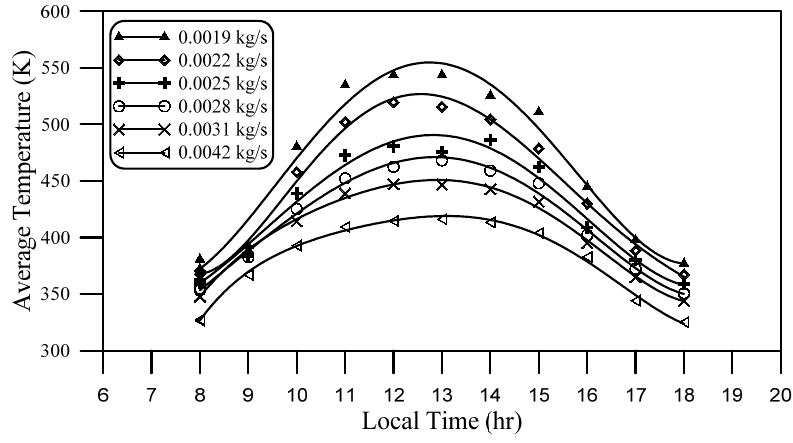
Figure 6. Daily profile of average output temperature for a 0.005 m diameter tube on a typical summer day.